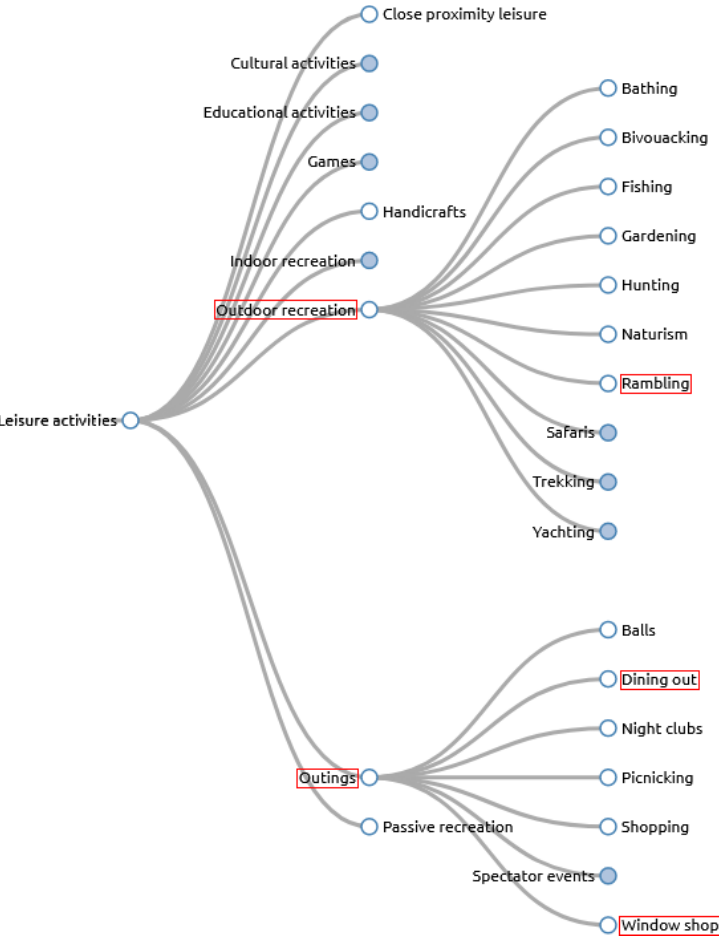
Figure 9. Concept Leisure activities of the tourism and leisure